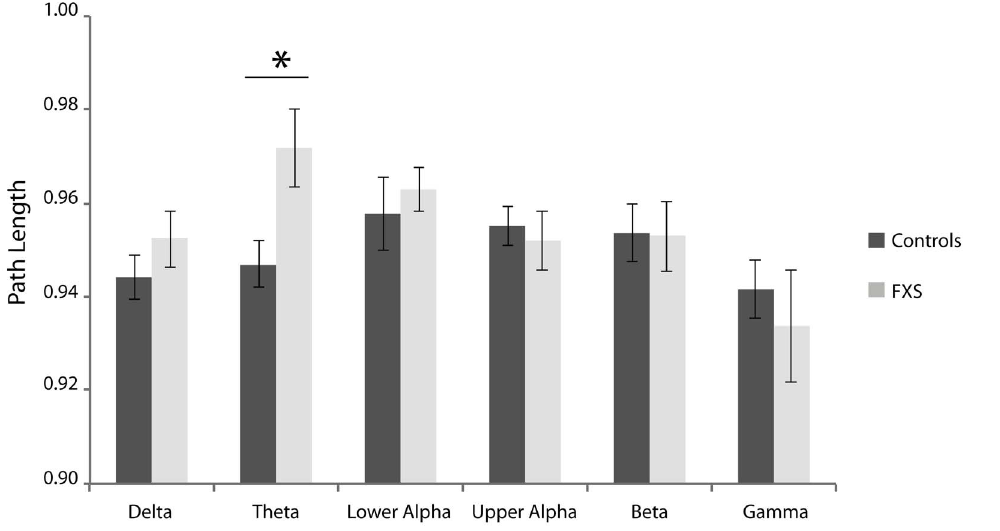
Figure 5. Mean normalized path length over all epochs for FXS and controls participants in the delta (0.05–4 Hz), theta (4–8 Hz), lower alpha (8–10 Hz), upper alpha (10–13 Hz), beta (13–30 Hz), and gamma (30–45 Hz) frequency range. Path length in the theta band is significant longer in FXS males as compared to controls. Asterisks represent significant differences at p , .05. Error bars represent standard error of the mean.